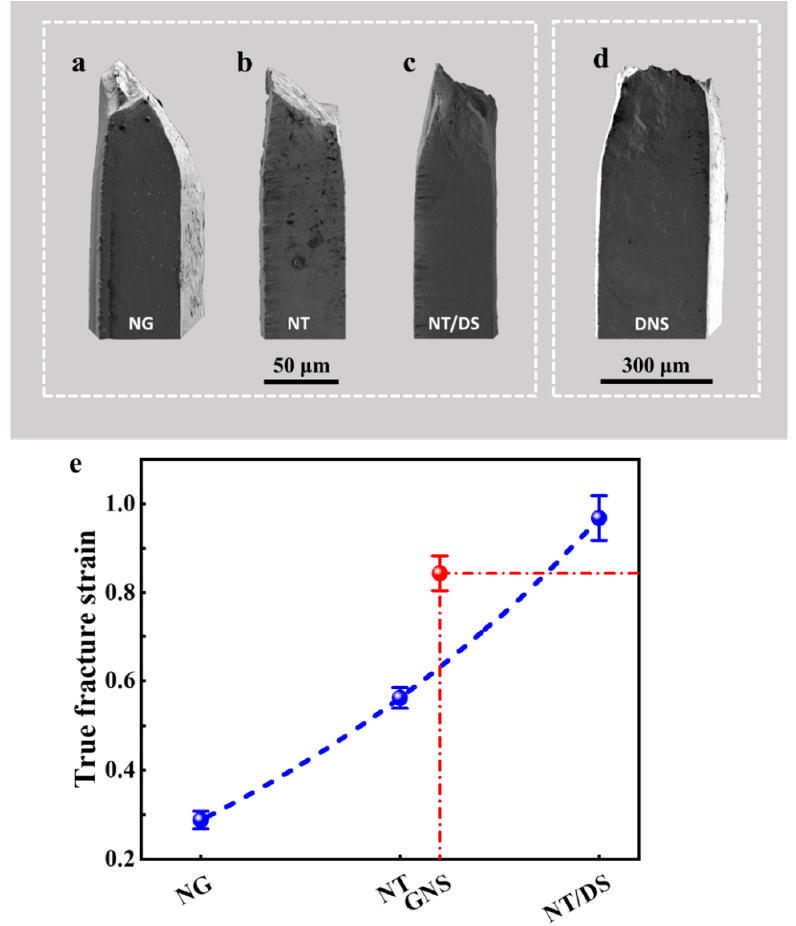
Figure 4. ( a – d ) Lateral morphology of the fractured NG, NT, NT/DS, and GNS specimens, respec- tively. ( e ) Variation of the true fracture strain of aforementioned specimens.